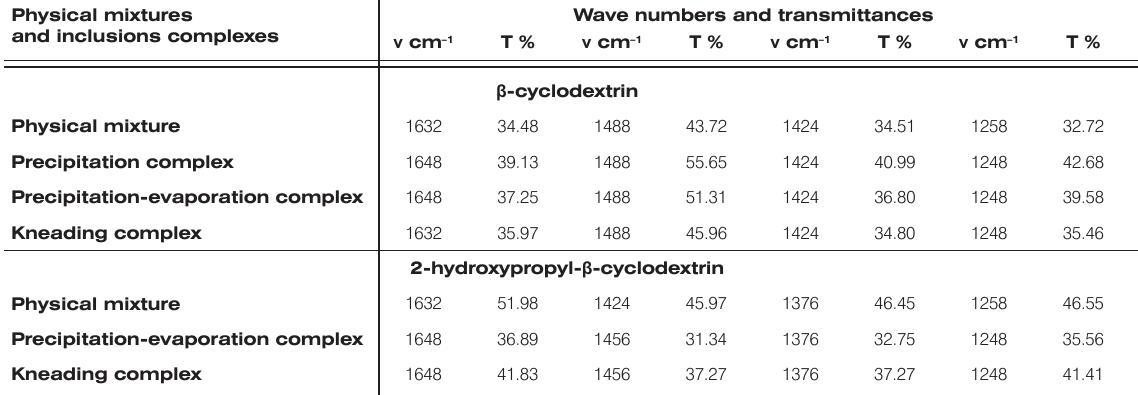
Table 4. Characteristic wave numbers and transmittances for physical mixtures and inclusion complexes of salicylamide. Physical mixtures and inclusions